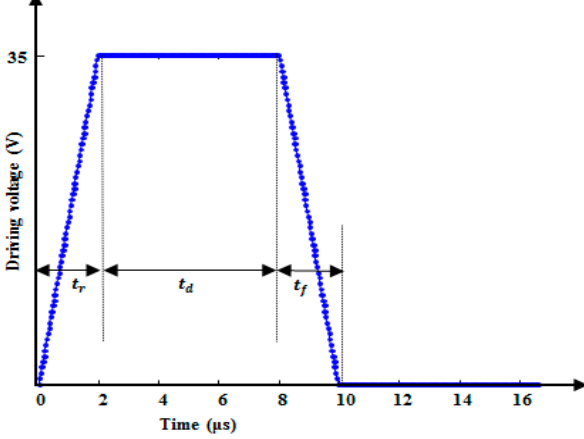
Figure 5. Input voltage waveform applied in both the LEM and FEM simulations.